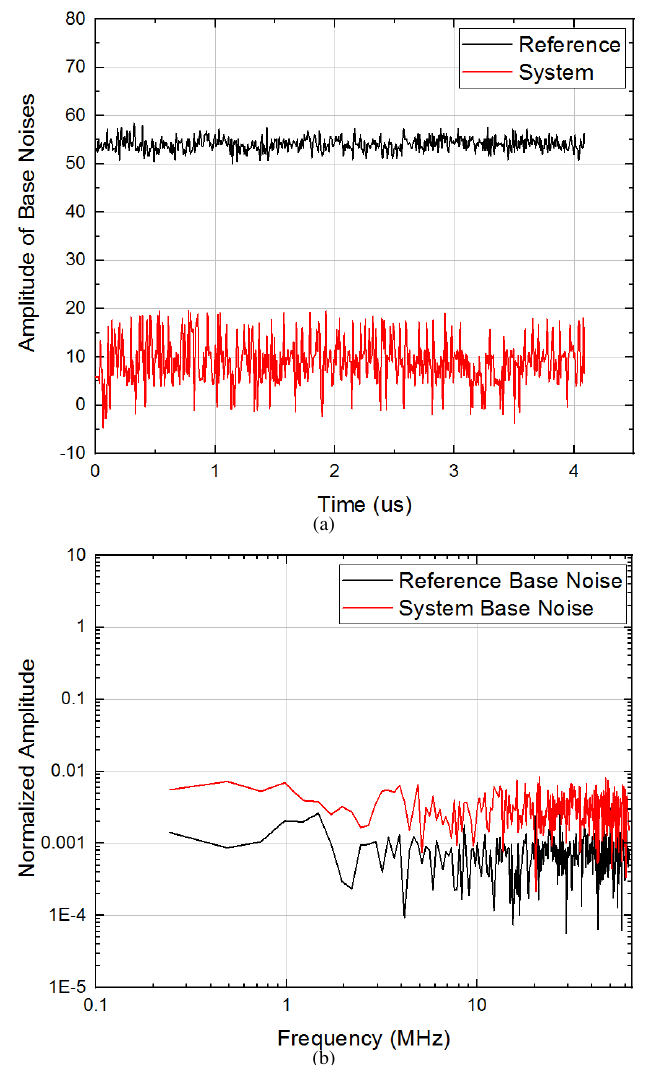
Fig. 5. Acquired data (a) and reference signal (b) shown in time and frequency domain. The total measurement is 512